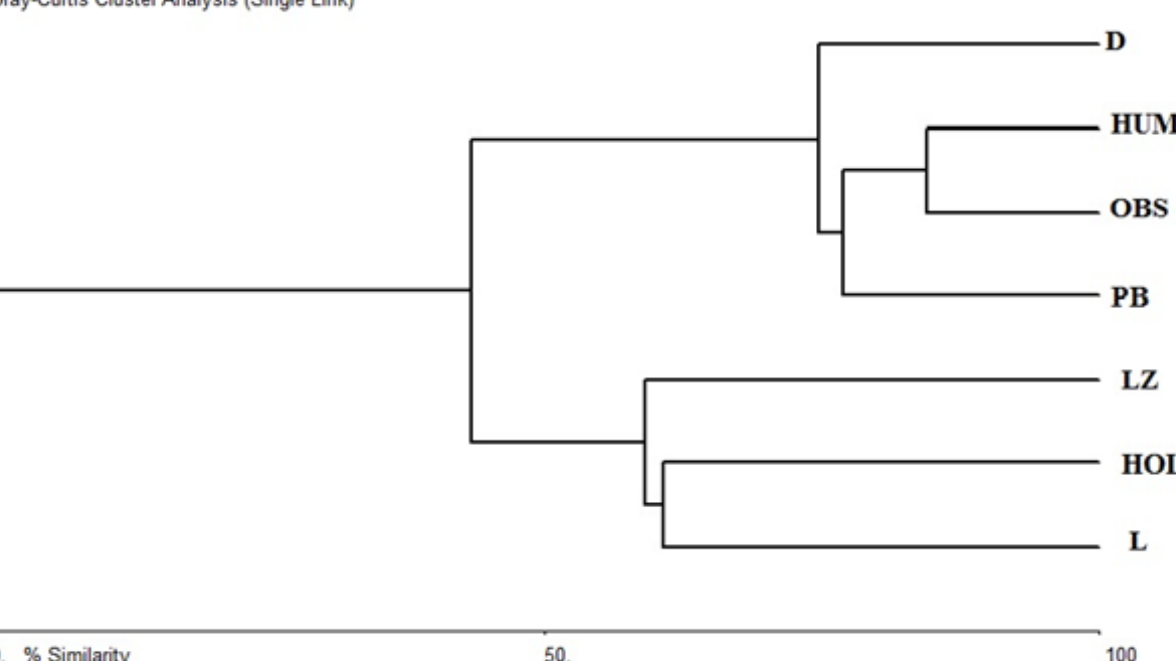
Figure 6. Relative similarity of species composition of beetle assemblages recorded in different habitats on the Yelnia peat bog. The scale on the horizontal axis is the Bray-Curtis coefficient of similarity (single linking method). Habitat symbols: LZ = lagg zone; PB = pine bog; HOL = hollow; HUM = hummock; OBS = open bog space; L = lakeshore; D = dome.